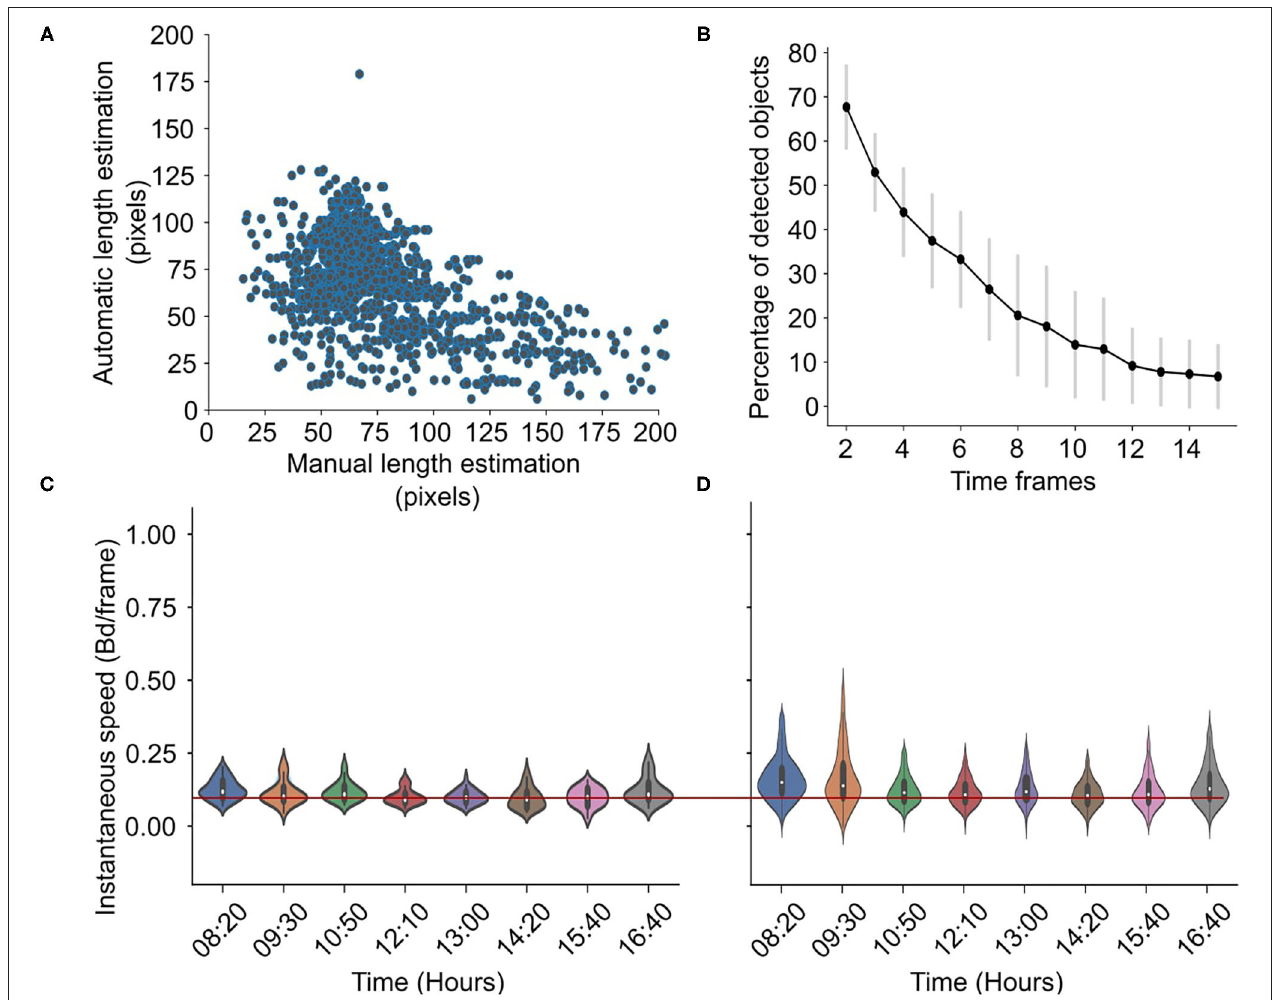
FIGURE 6 | Accuracy in cages. Scatterplot showing the manual vs. automatic length estimation (A) and the percentage of detected objects for different time frames (B) . Violin plots showing the manual (C) vs. automatically (D) estimated speed distribution for different hours in a day in cages, with a reference red line for easier comparison. The speed is the normalized speed, i.e., it is expressed in body-lengths per